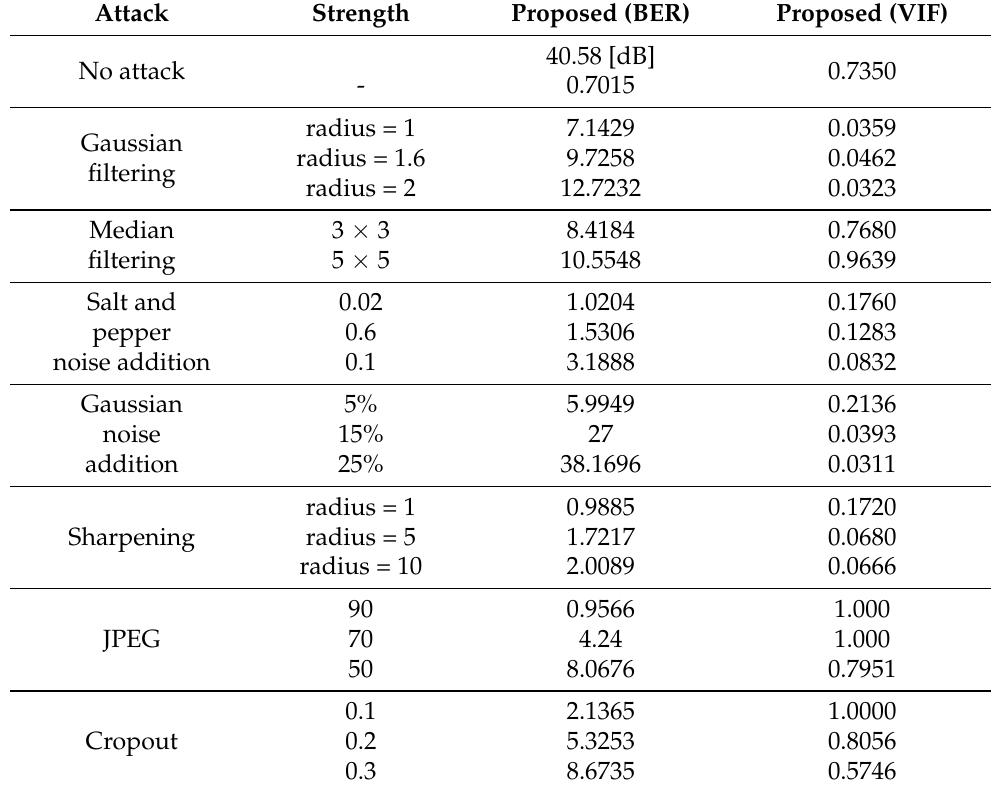
Table 2. Performance analysis of the deep learning-based